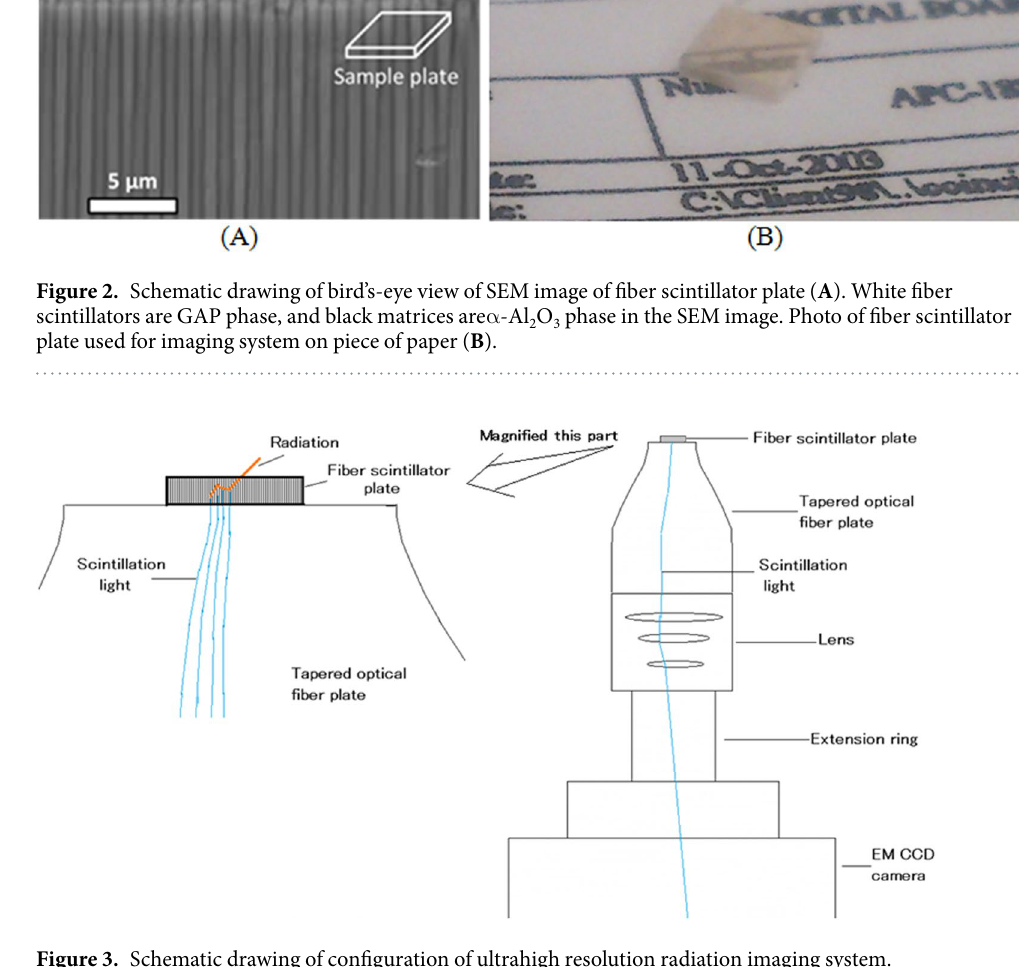
Figure 3. Schematic drawing of configuration of ultrahigh resolution radiation imaging